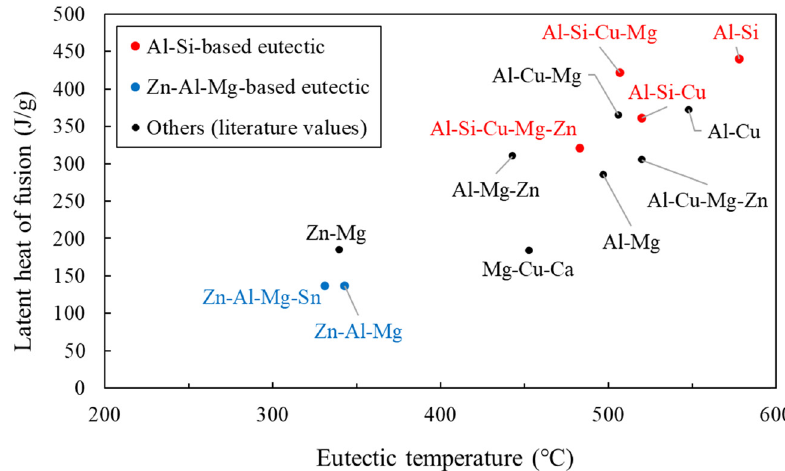
Figure 5: Eutectic temperature and latent heat per weight.